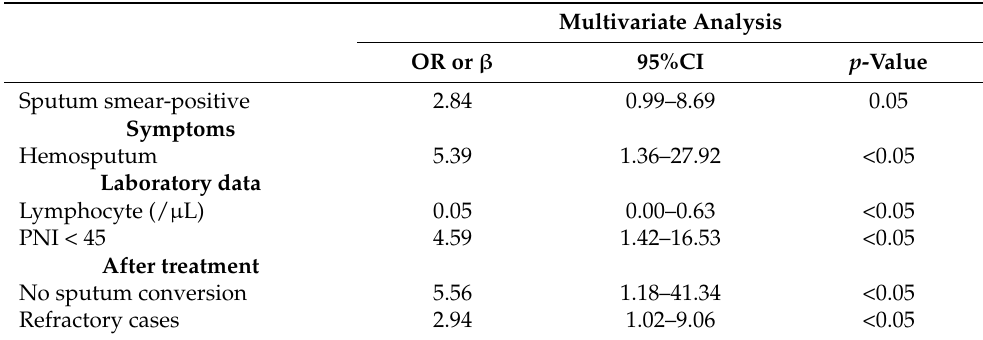
Table 5. Multivariate analysis of the MAC-PD patients with a BMI < 18.5 kg/m 2 who received